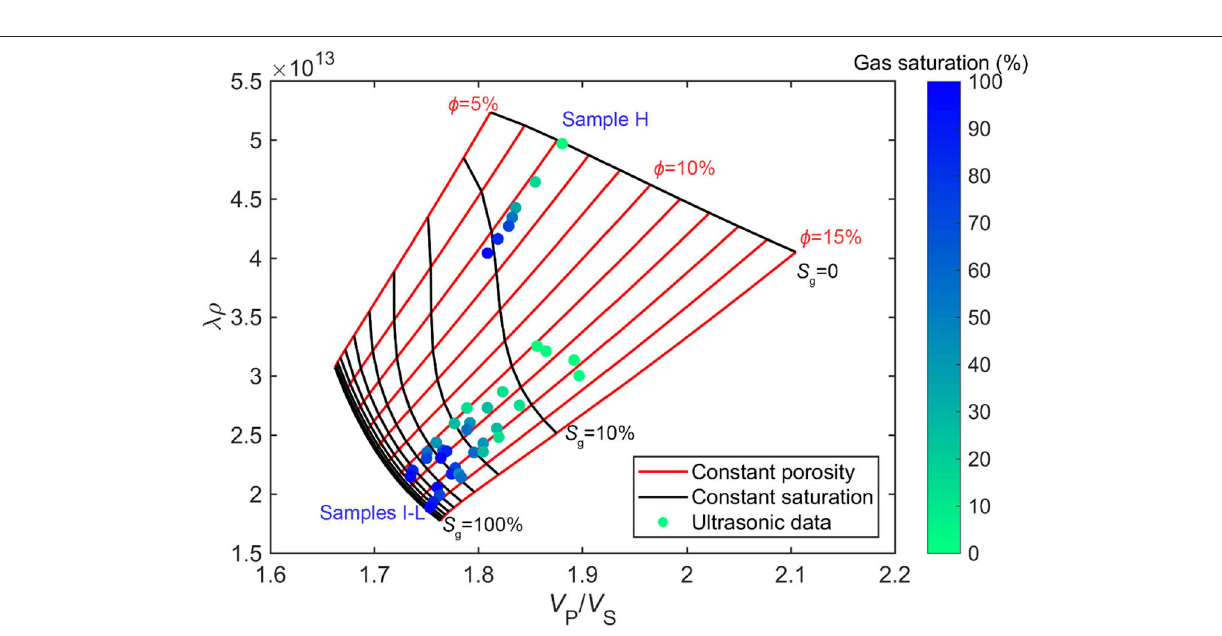
Frontiers in Earth Science |